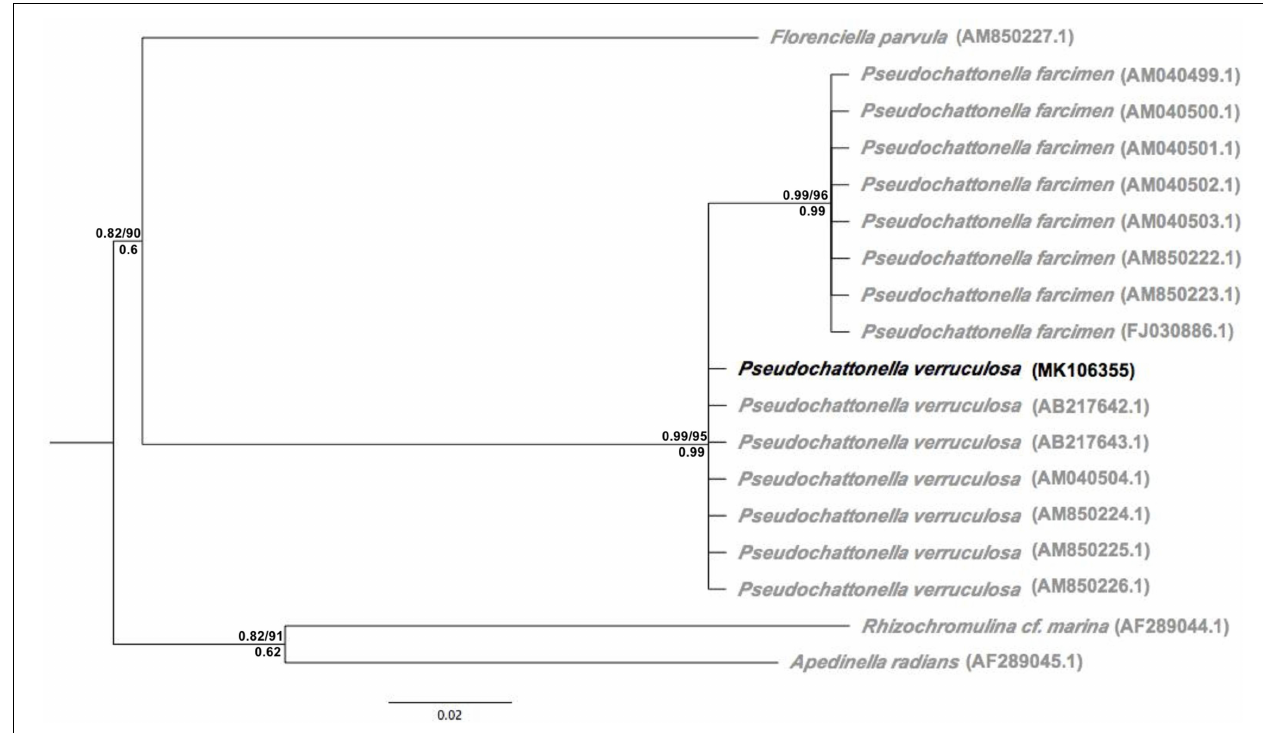
FIGURE 2 | Maximum likelihood phylogeny derived from partial nuclear LSU sequences (D1–D2 region) including the Chilean P. verruculosa strain (ARC498) (depicted in black). Support values are shown on each branch: aLRT/ML bootstrap (above) and Bayesian posterior probability